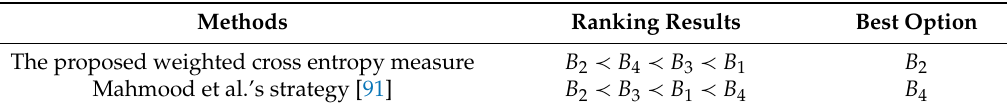
Table 2. The results of the investment problem obtained from different